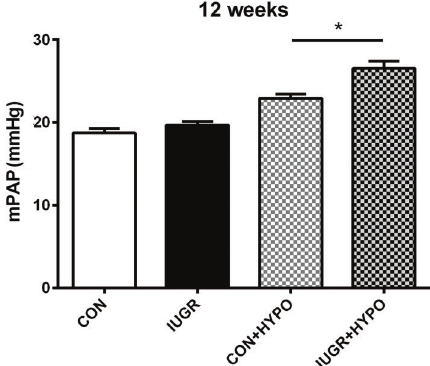
Figure 1. Intrauterine growth retardation (IUGR) and control- hypoxia and normoxia rat mean pulmonary artery pressure (mPAP). CON: control group; IUGR: IUGR group; CON + HYPO: control group with 2-week hypoxia; IUGR + HYPO: IUGR